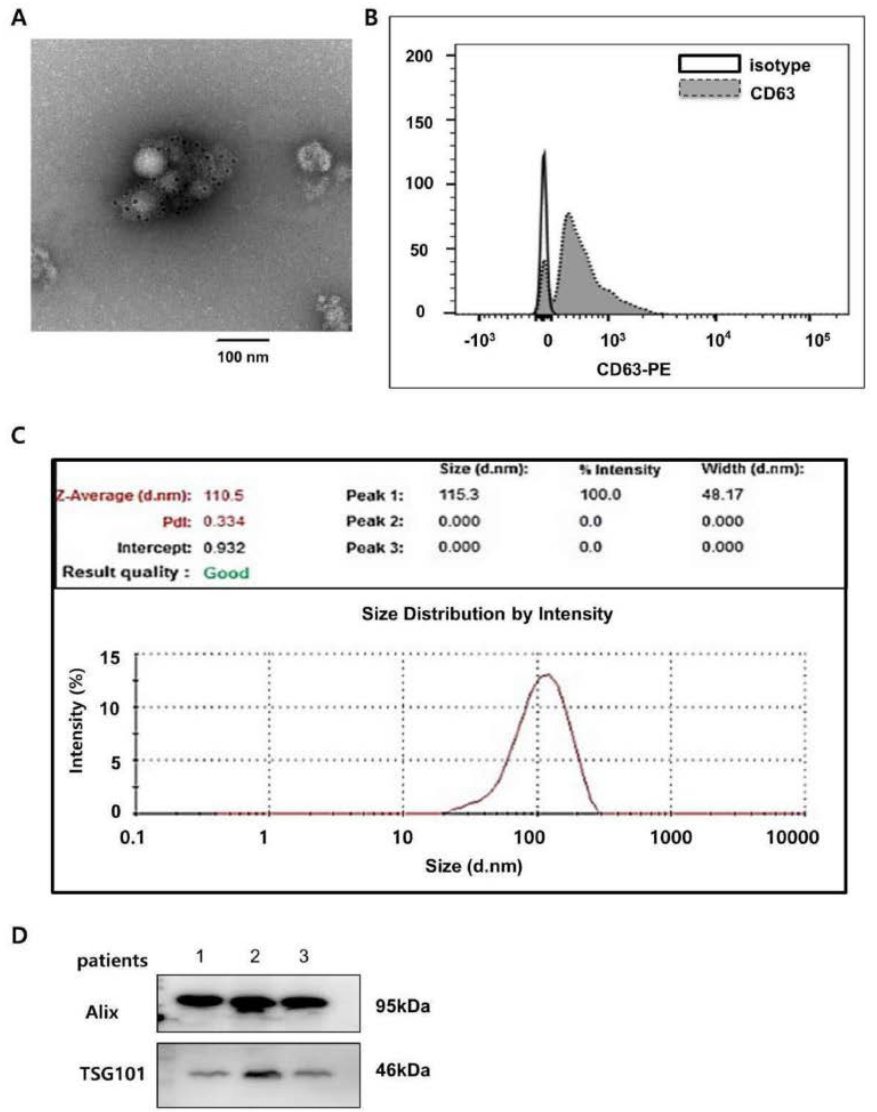
Figure 1. Urinary exosome characterization. ( A ) CD63 immunogold stain image of exosomes. Representative transmission electron micrographs of exosomes labeled with gold particles (black dots) are shown. ( B ) Flow cytometry analysis of the exosomal CD63 marker. ( C ) Size distribution of urinary exosomes analyzed by Zeta sizer. ( D ) Western blot analysis of the expression of exosomal markers Alix and TSG101 in urinary exosome proteins. ABMR, antibody − mediated rejection; TCMR, T cell − mediated rejection; NOMOA, no major abnormality; BKVN, BK virus nephropathy. FC, fold